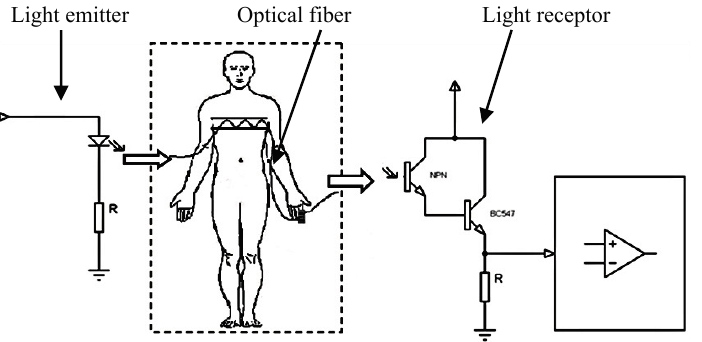
Figure 5. Electronic circuits used for transmission and reception of light in the fiber